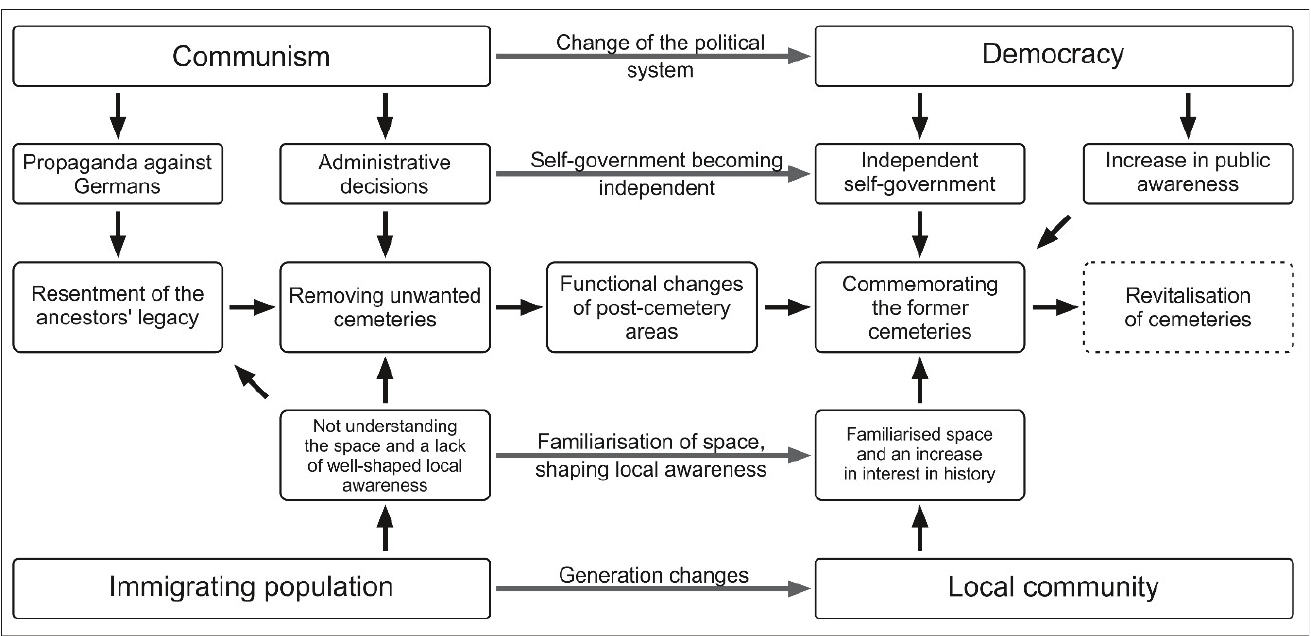
Figure 19. Change in the approach to Gdańsk cemeteries as a legacy of the previous